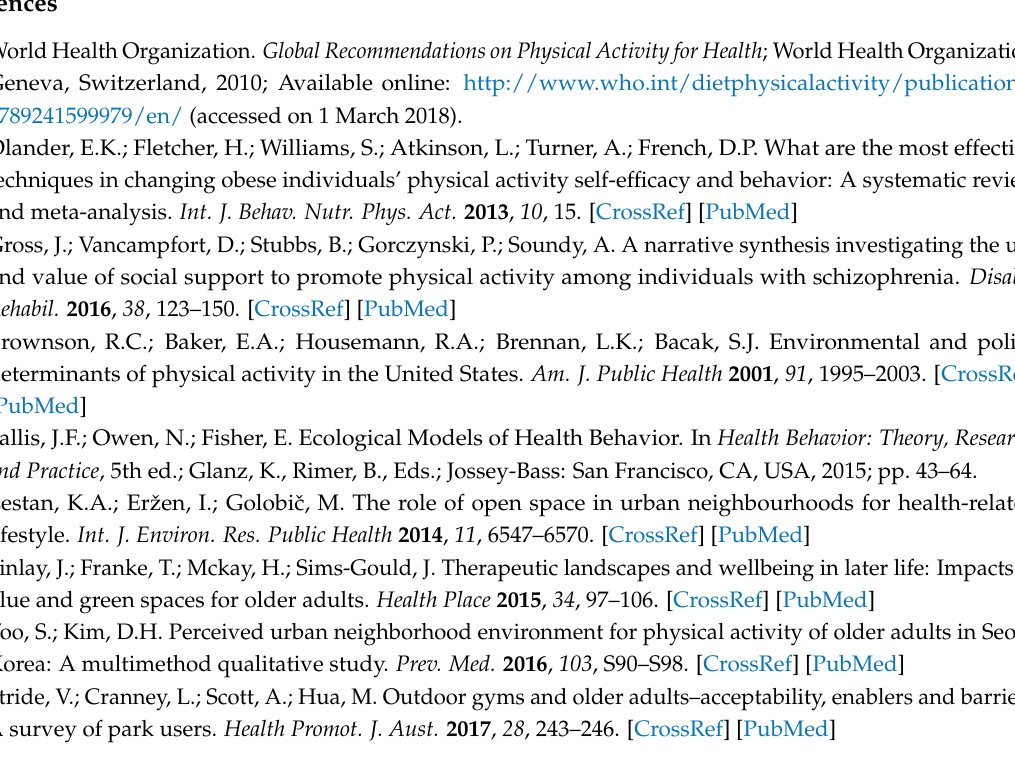
s1, Table S1: Data Extraction, Table S2: Quality